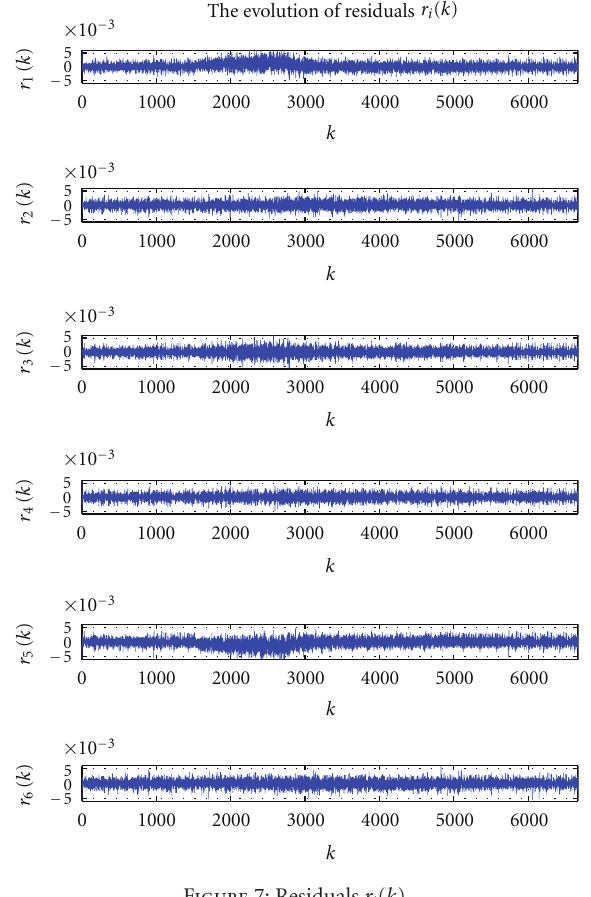
Figure 7: Residuals r i ( k ).